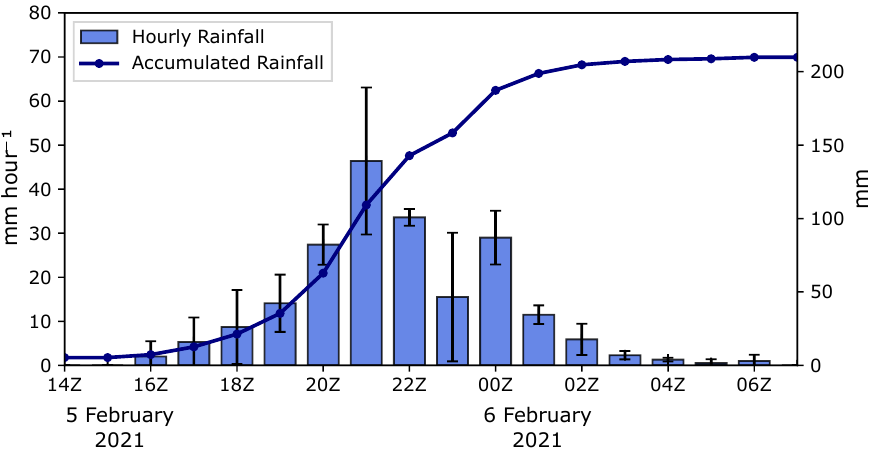
Figure 2. Time series of hourly rainfall averaged from three rain gauge stations. The vertical line indicates a standard deviation and the contour line indicates accumulated precipitation from 00Z 5 February to 07Z 6 February